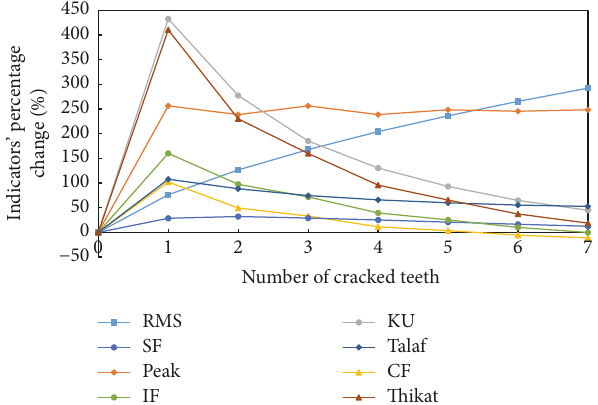
Figure 27: Performance of different time domain indicators applied to the residual signal for the first multiple-crack scenario.